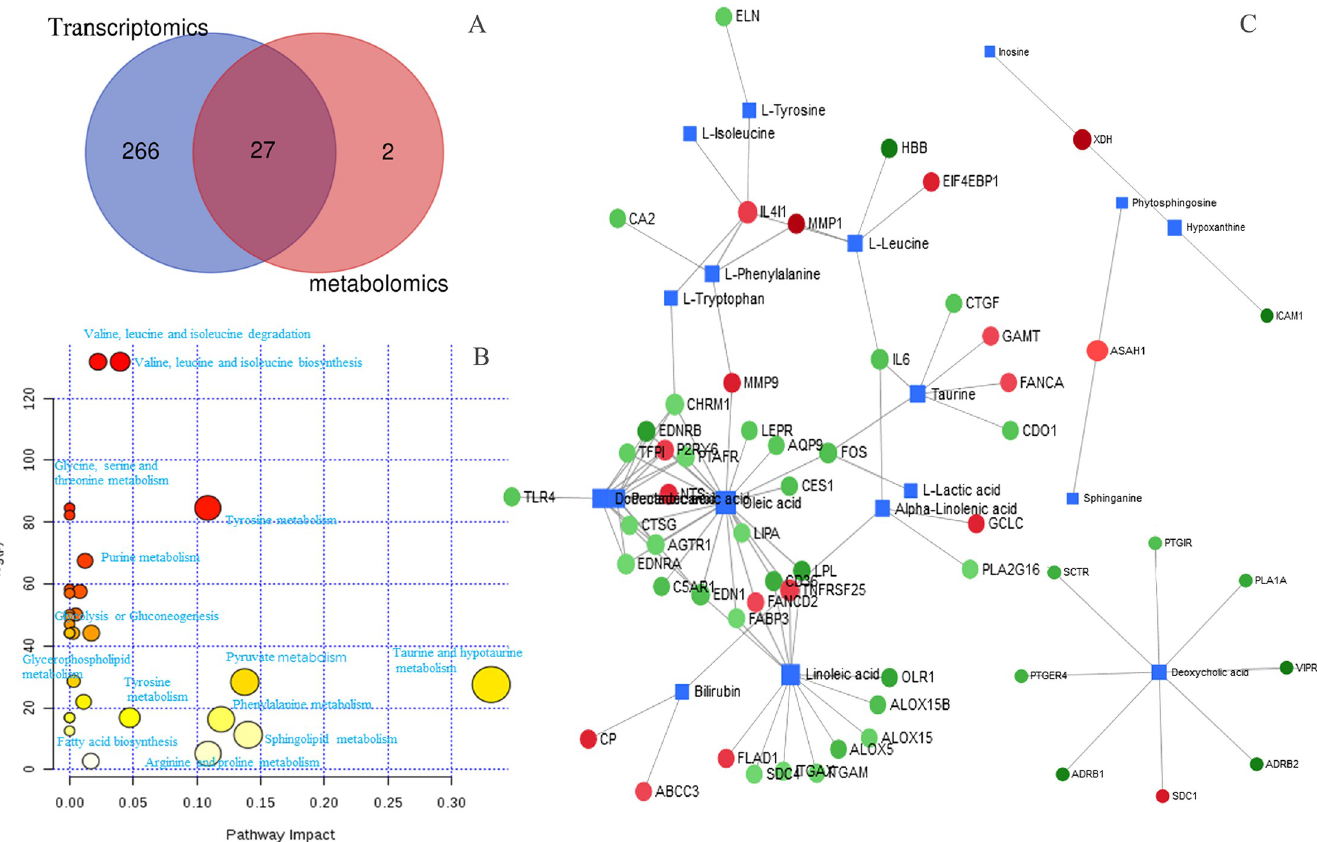
Fig 5. Venn plot (A) of metabolic pathways enriched by metabolomics and transcriptomics; pathway analysis plot (B) of metabolites with a significant difference between samples from NSCL patients and healthy controls; connected network (C) of metabolites and genes of metabolomics and transcriptomics analysis. The quadrangle in blue indicates differential metabolites, and the nodes in green or red indicate increased or decreased expression of genes.